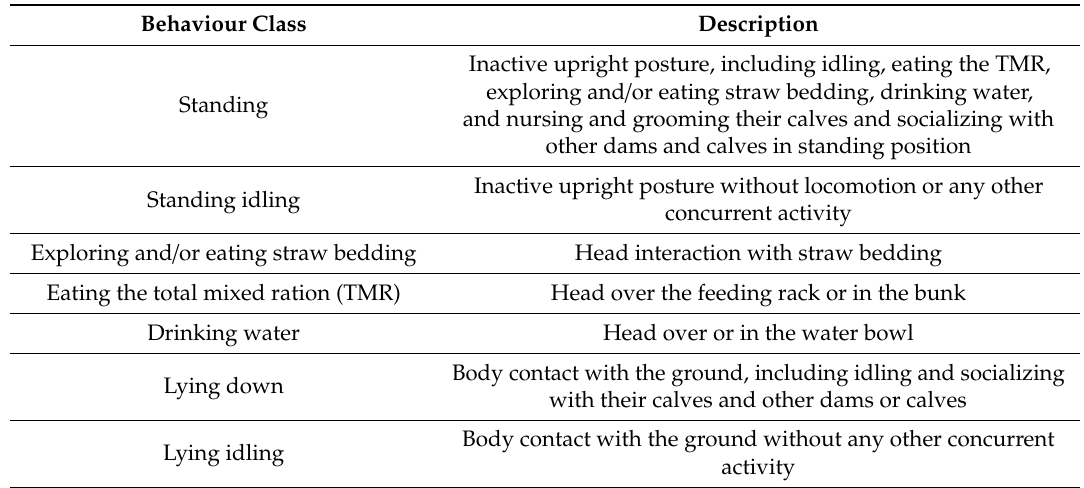
Table 2. Recorded behaviours in the